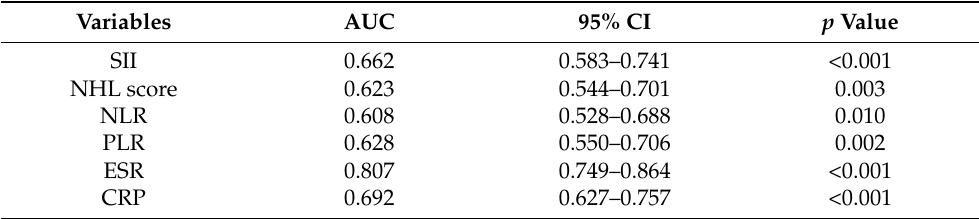
Table 5. Analysis by receiver operating characteristic curve of hematological indices and acute phase reactants for remission.